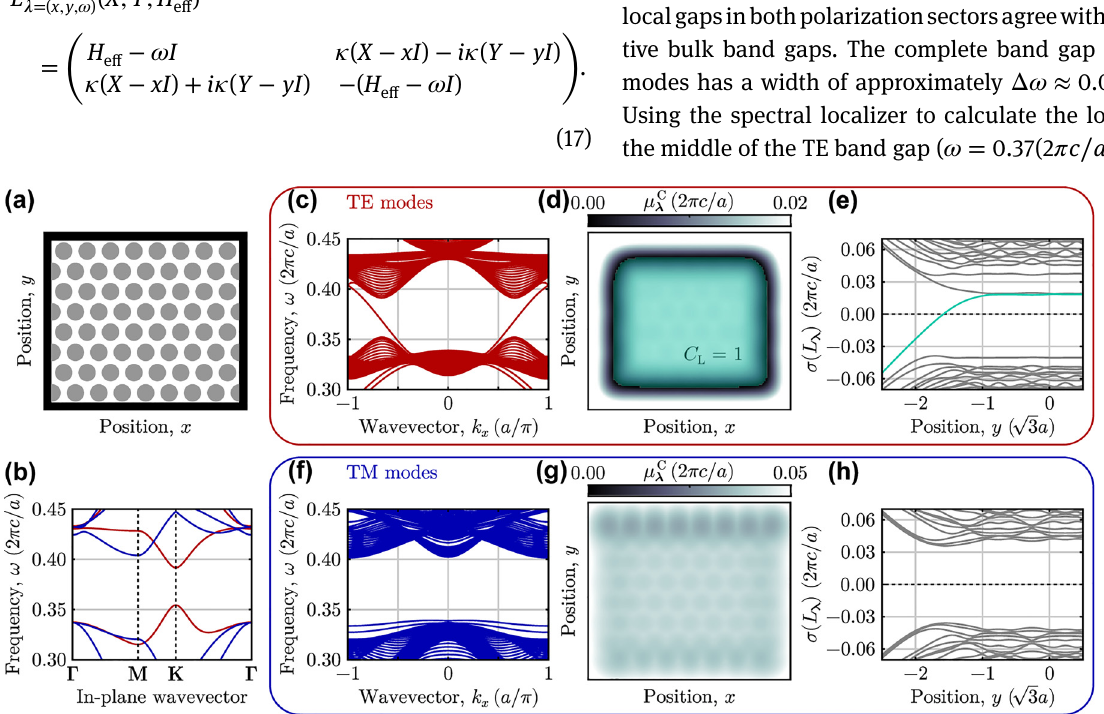
Figure 1: Applying the spectral localizer to a photonic Chern insulator. (a) Schematic of a 2D photonic crystal consisting of high-dielectric = 14 for j = x , y , z , with radius r = 0.37 a embedded in a gyro-electric background, 𝜀 = 1 and 𝜀 = − 0.4 i . The lattice constant is a rods, 𝜀 jj jj xy = 1. The black boundary indicates where perfect electric conductor boundary conditions were used. (b) Bulk band and all materials have 𝜇 jj structure for both the TE (red) and TM (blue) bands. (c) Ribbon band structure for the TE fields with PEC boundaries along the two nonperiodic ), at 𝝀 = ( x , y ,𝜔 = 0.37(2 𝜋 c ∕ a )) with 𝜅 = 0.25. The gap is in units of (2 𝜋 c ∕ a ). The edges. (d) Spatially resolved local gap, 𝜇 C 𝝀 ( X , Y , H eff = 1 is shown in lime, and the system’s scale is identical to (a). (e) Full localizer spectrum at topological region of the system with C L 𝝀 = ( x = 0 , y ,𝜔 = 0.37(2 𝜋 c ∕ a )). The eigenvalue that is responsible for the change of the signature of L 𝝀 is highlighted in lime. (f)–(h) Similar to (c)–(e), except for the TM